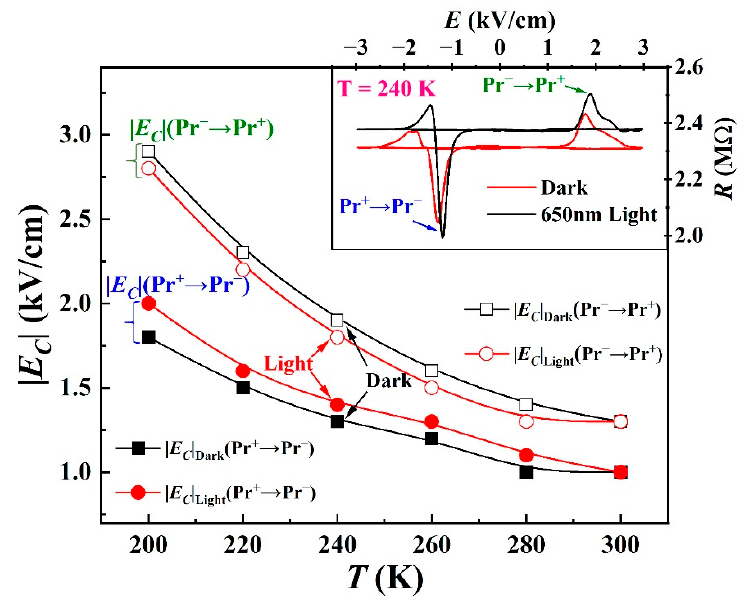
Figure 5. The temperature dependence of coercive electric fields with and without light irradiations. The inset shows the variation of resistance under symmetric bipolar electric-field cycling at 240 K.